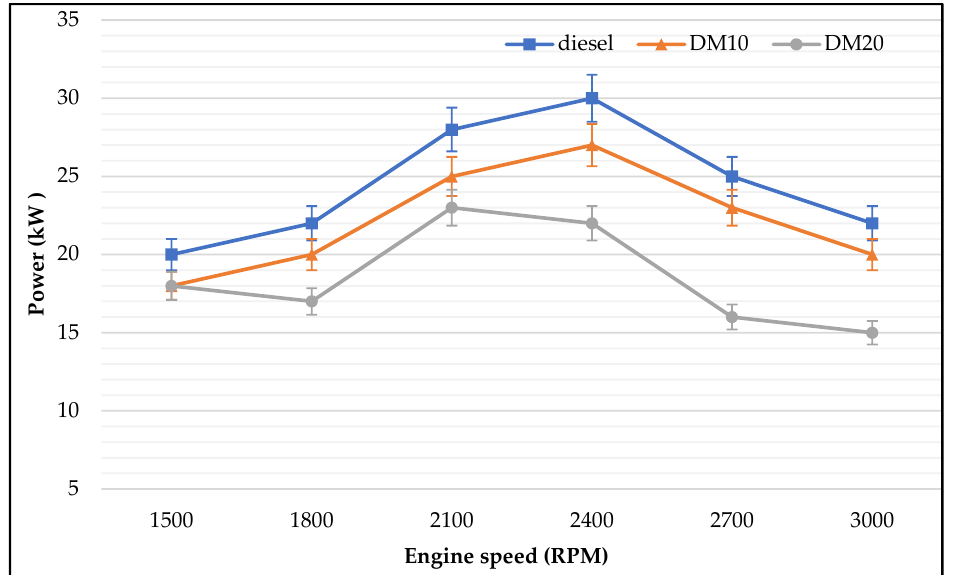
Figure 12. Engine power at different engine speeds.